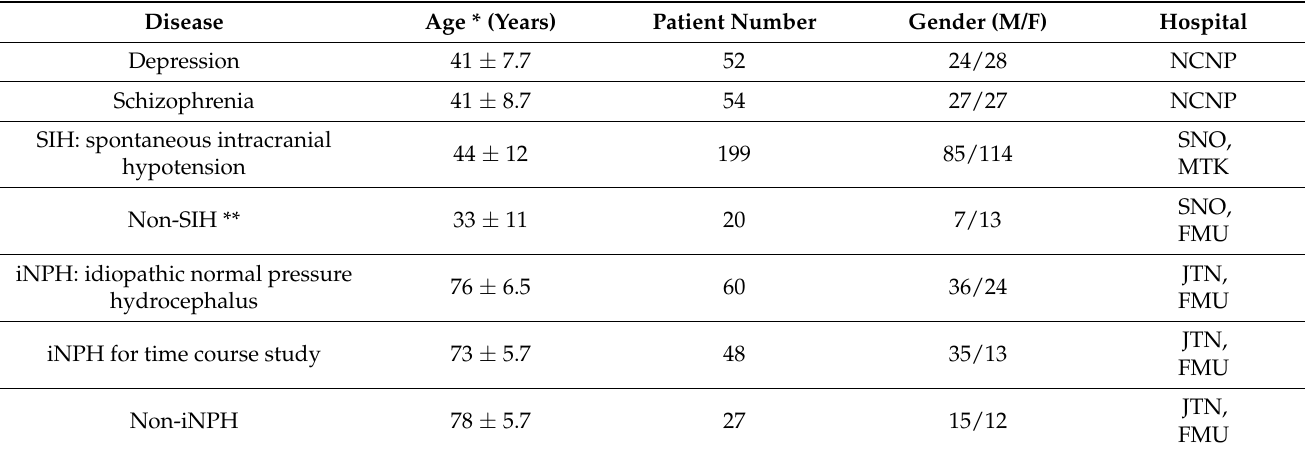
Table 13. Patient